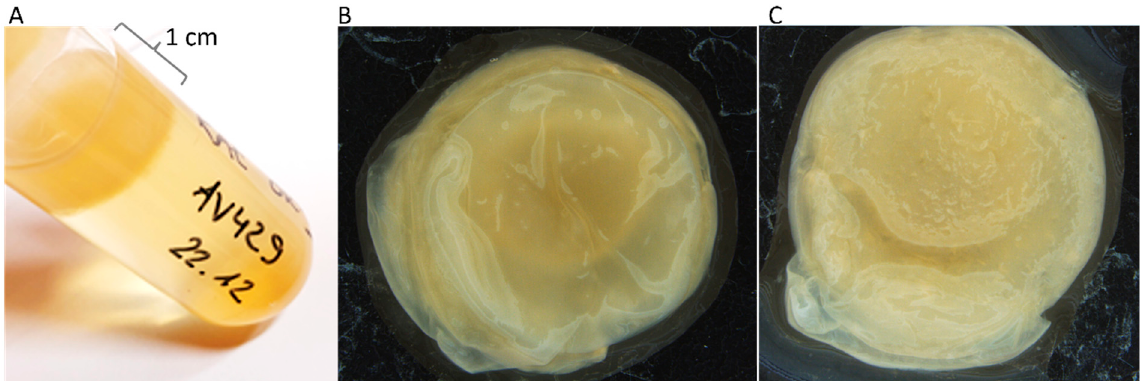
Figure 3. Gluconacetobacter entanii AV429 forms a thick pellicle at the top of the RAE medium containing 1 vol% ethanol and 2.5 vol% acetic acid ( A ). The pellicle picture was taken from the top ( B ) and from the bottom ( C ). Biofilm images were taken by microscopy with 6.3 magnification.